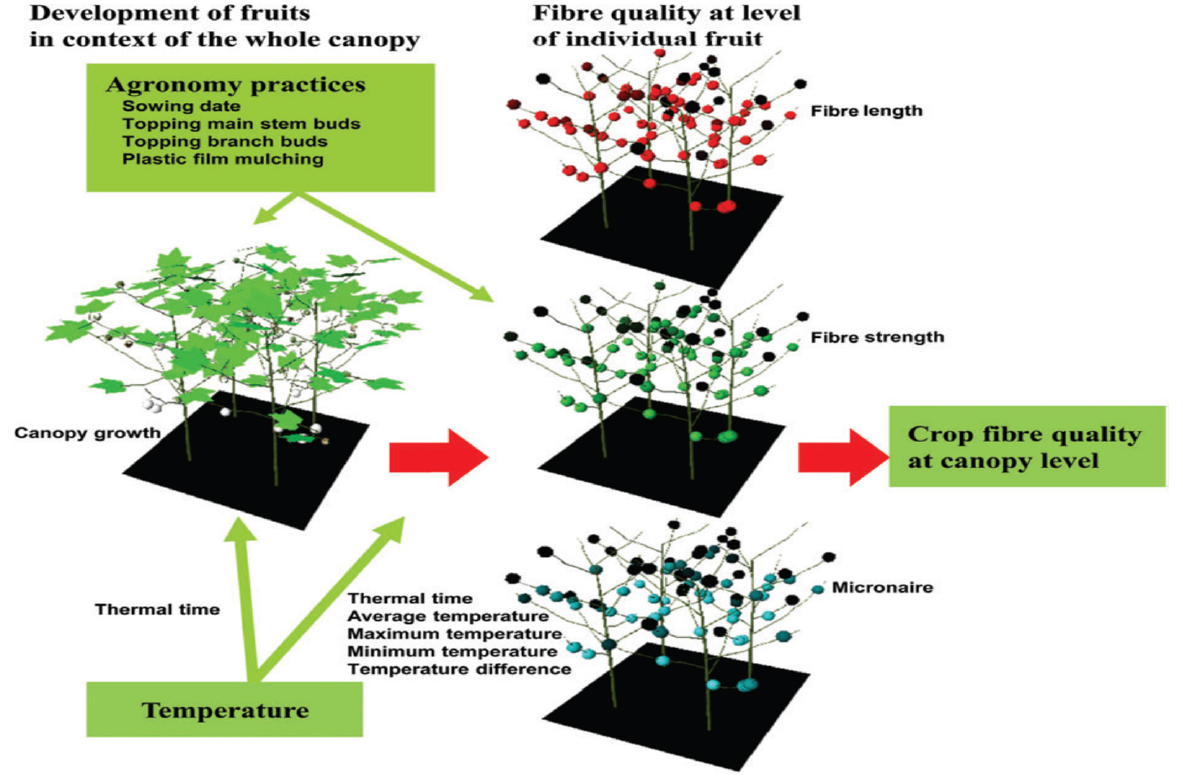
Figure 10. Flowchart of FSPM model to demonstrate temperature differences and growth functioning of the cotton plant.